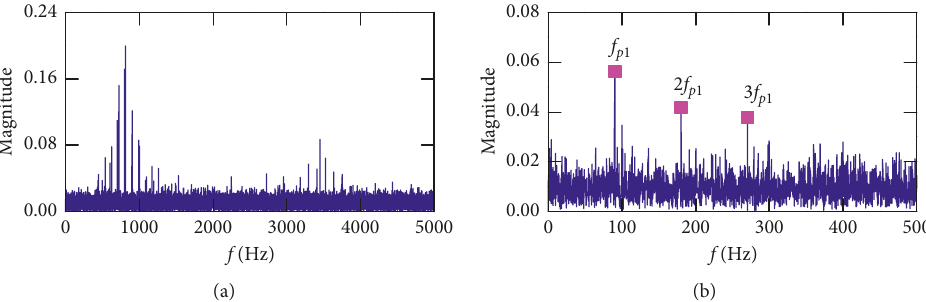
Figure 4: Fourier and envelope spectra of simulation signal: (a) Fourier spectrum; (b) squared envelope